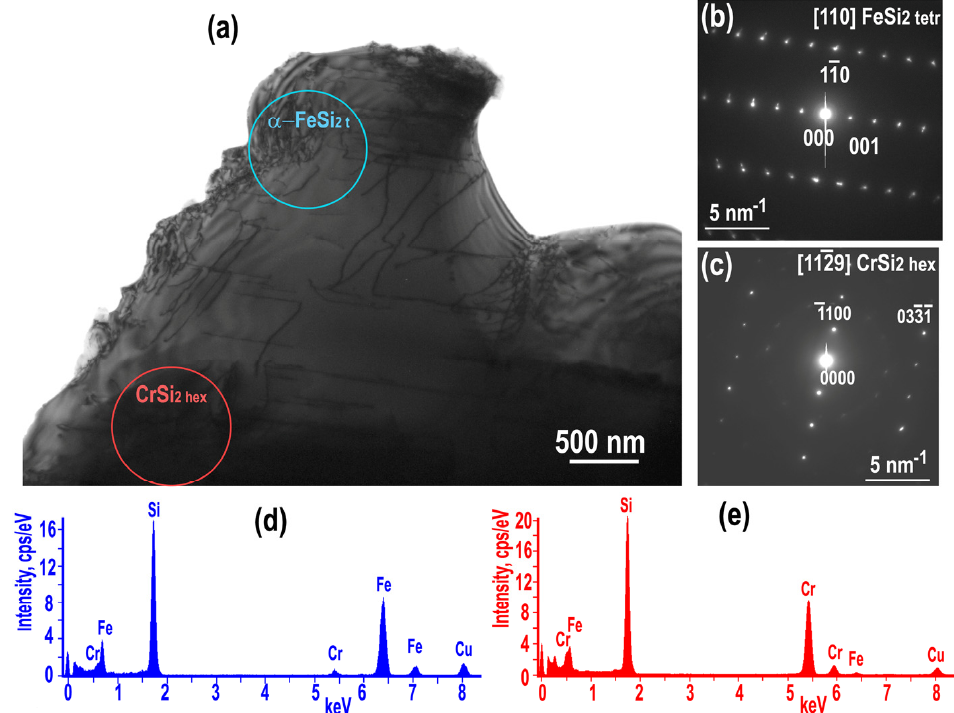
Figure 4. Non-annealed sample: TEM image with α -FeSi 2 and CrSi 2 hex phases ( a ), the corresponding SAED patterns obtained from α − FeSi 2 [110] ( b ) and [1129] CrSi 2 directions ( c ); spectra obtained from the α -FeSi 2 ( d ) and CrSi 2 areas showed all elements ( e ).